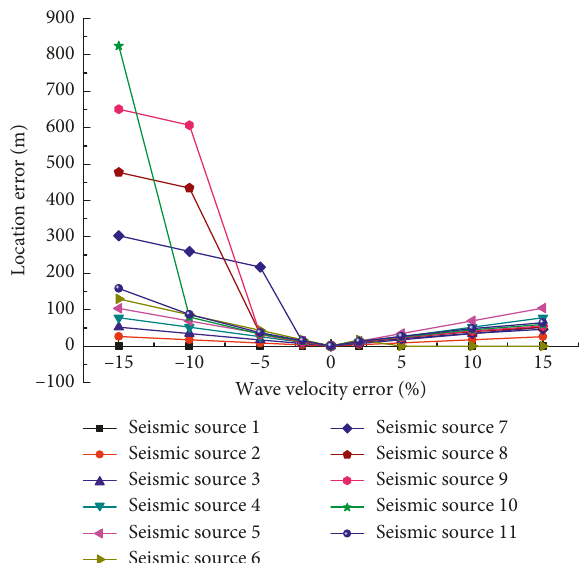
Figure 10: Location distance error distribution of different